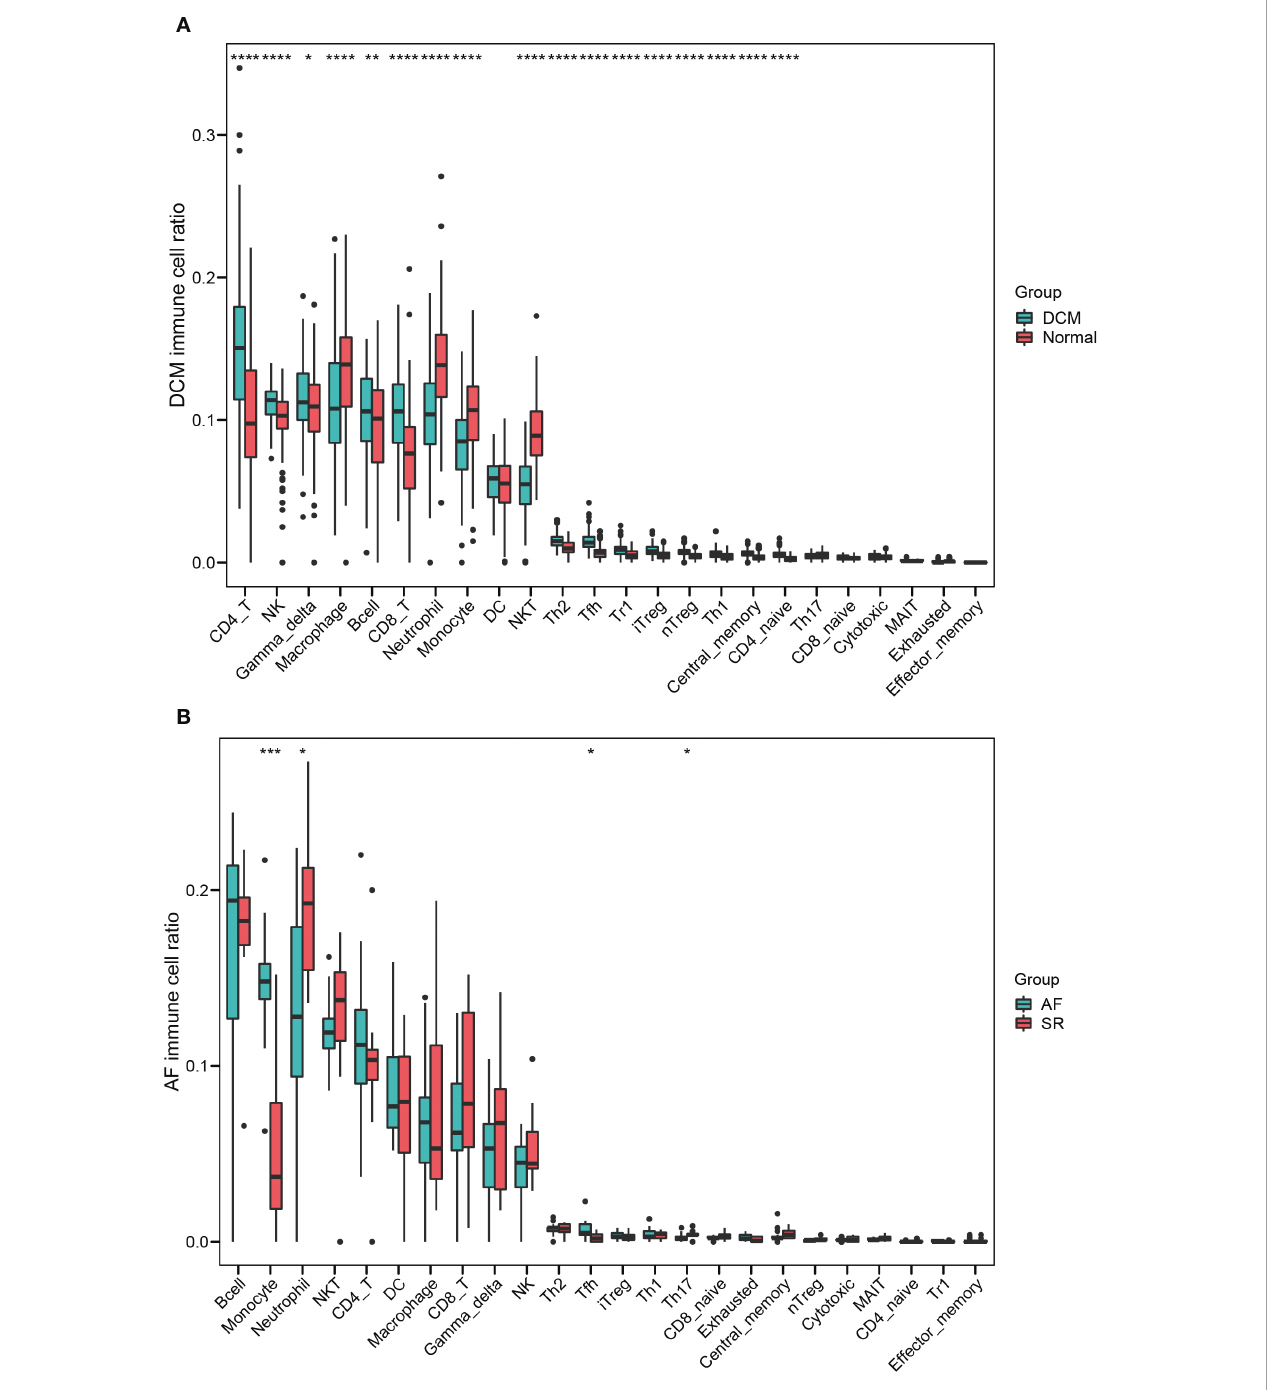
FIGURE 6 Identifying the signi fi cantly different in fi ltrates of immune cells in DCM and AF. (A) Boxplot of immune cell ratio in DCM. (B) Boxplot of immune cell ratio in AF. Wilcoxon test: * P < 0.05, ** P < 0.01, *** P < 0.001, **** P <